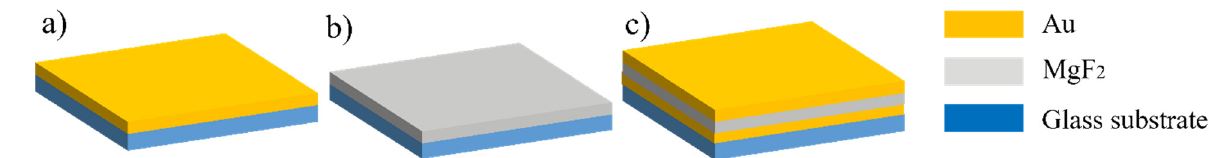
Figure 8. The diagram of back side ablation technology.